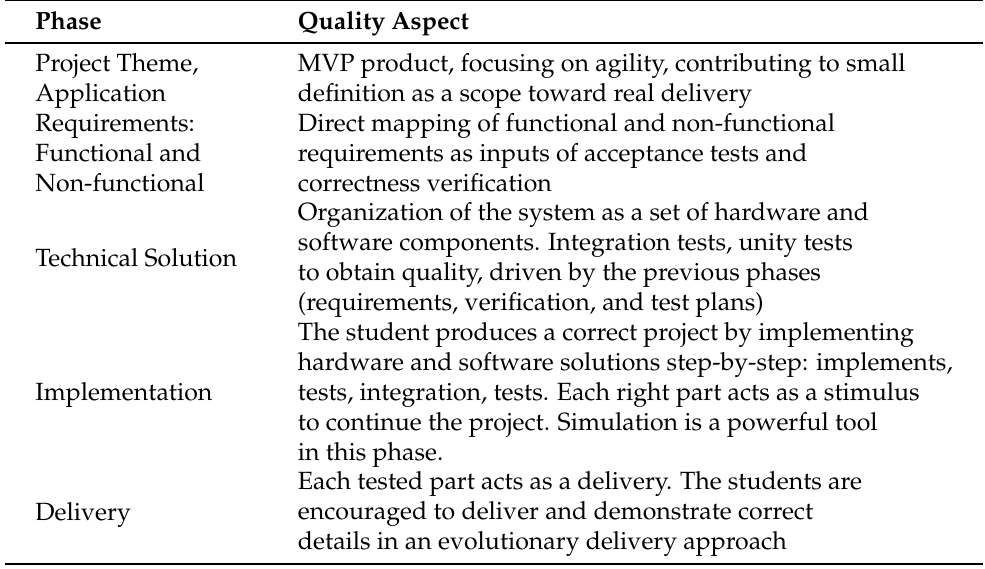
Table 1. Quality aspects of project